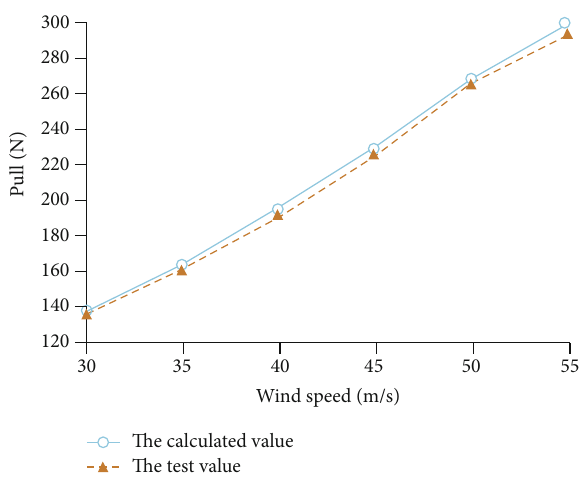
Figure 29: Calculated value and test value.